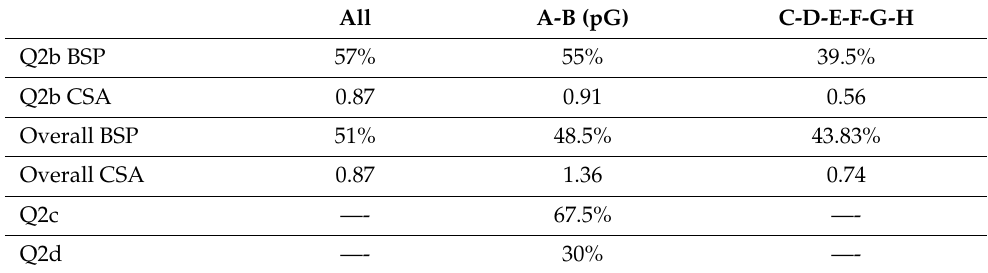
Table 5. Performance of players and non-players in Q2b and overall Q2a+Q2b questionnaires. All A-B (pG) C-D-E-F-G-H Q2b BSP 57% 55%